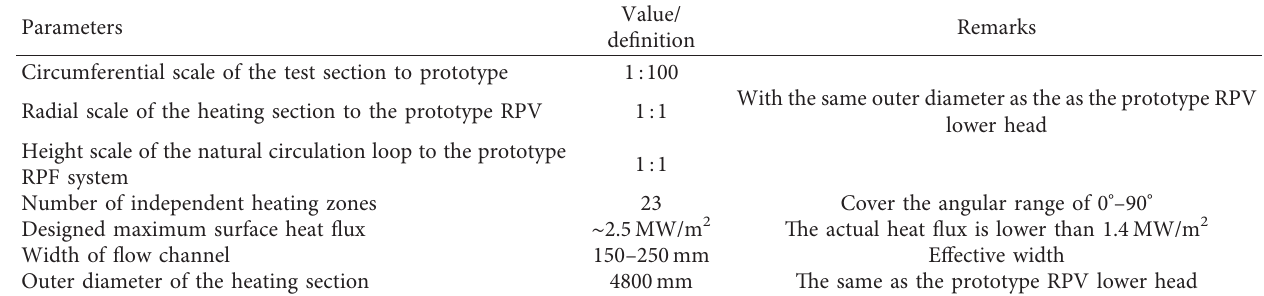
Table 2: Key parameters of REVECT test section.